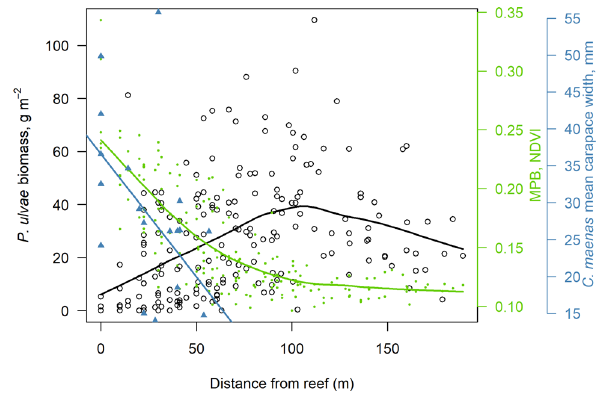
Fig. 5 The spatial footprint of C. gigas reefs on an index of crab foraging intensity (mean carapace width), the biomass of mud fl at grazers, and MPB in the vicinity of 10 s of m. Crab mean carapace width is shown by blue triangles, right y -axis, with the blue linear regression line y = 36.6 - 0.33x ( P = 0.014, degrees of freedom = 18, R 2 adj = 0.25). P. ulvae biomass shown by open black circles, left y -axis, smoothed black curve, which shows a similar pattern to mean individual mass, also for M. balthica (Supplementary Fig. S16). MPB shown by small solid green circles, right y - axis, smoothed green curve. Smoothed curves calculated by fi rst degree LOESS with a smoothing parameter of